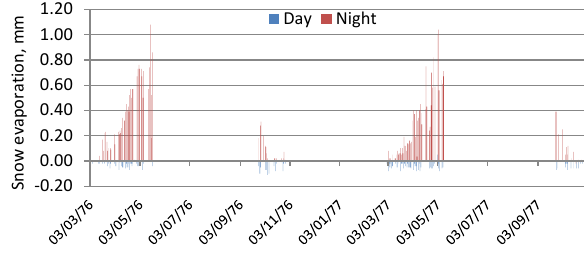
Table 4. Mean, maximum and minimum snow water equivalent (SWE) (mm) before spring freshet at different watersheds within the KWBS.